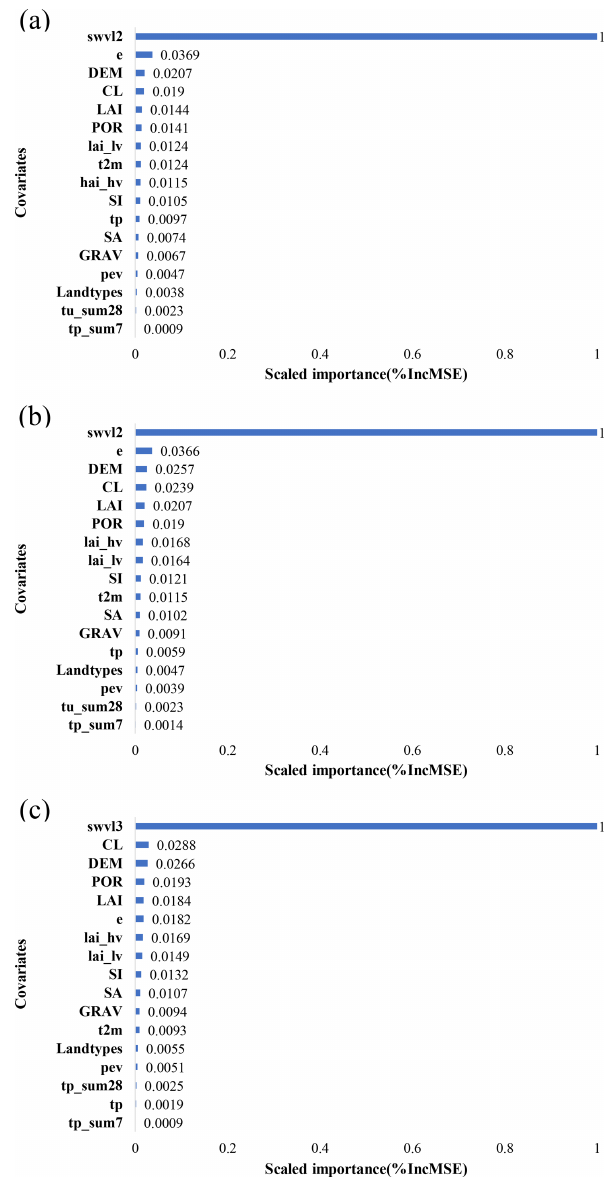
Figure 8. Relative importance of predictors for the random forest (RF) model at soil depths of (a) 10cm, (b) 20cm, and (c)